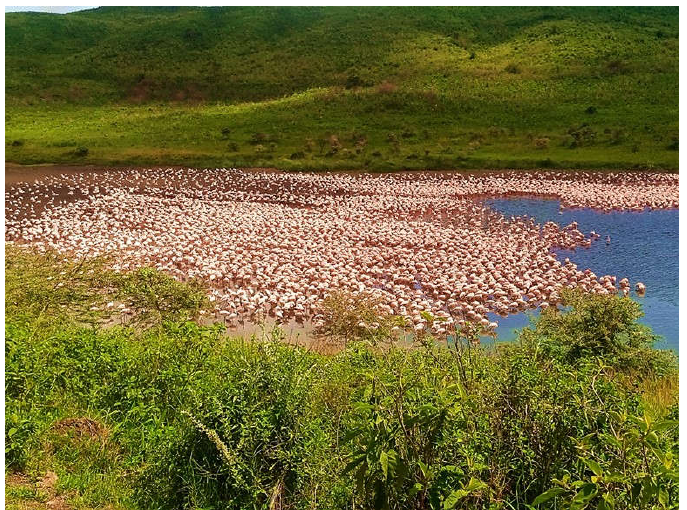
Figure 2. A flock of lesser flamingos captured wading and feeding along the shore area of Lake Big Momella, northern Tanzania, during one of the counting sessions (April 2021).